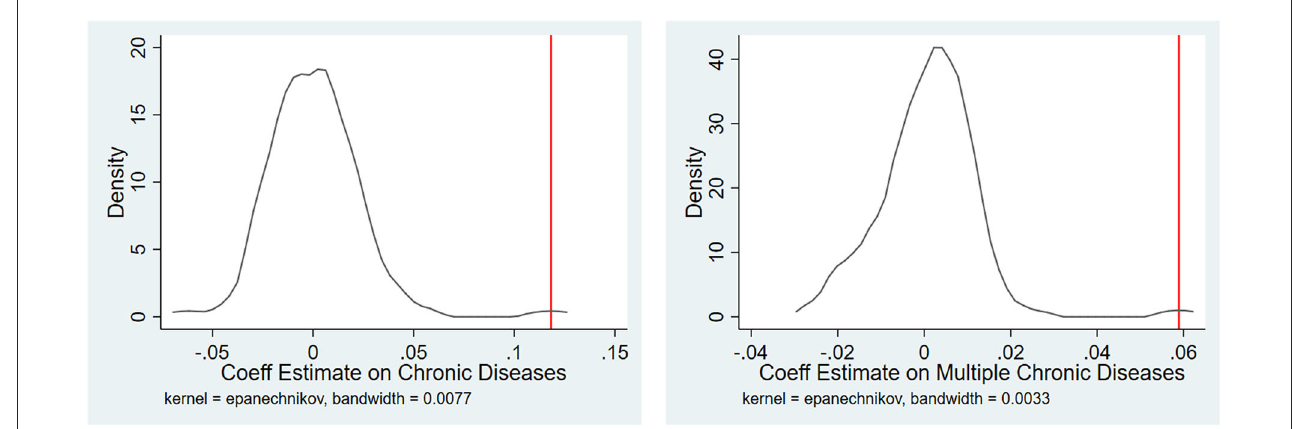
FIGURE3 RD Estimates of the effect of the latitude boundary on chronic diseases, placebo estimates. The graphs show the distribution of the RD estimates by using a nonparametric method obtained from 1,000 random permutations of the boundary. Each placebo estimate assigned a false latitude boundary and then used a triangle kernel local linear regression and the bandwidth selected by the common MSE-optimal bandwidth selector to estimate the effect of the boundary on chronic and multiple chronic diseases. The vertical solid lines denote the actual